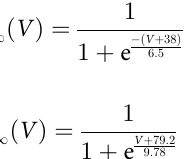
( Fig 2E : σ = 0–2 mV ); I = -1 . 85 μA/cm 2 ; and A bias Fig 2D : A = 0–1 μA/cm 2 in